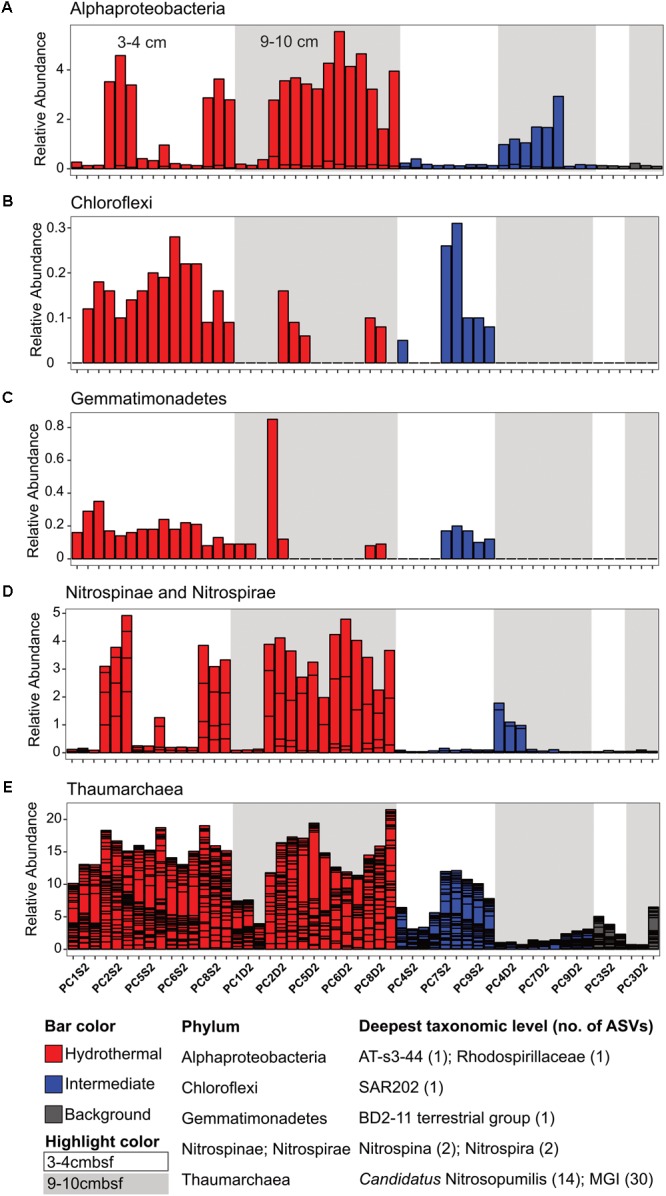
Select ASVs associated with (A) Alphaproteobacteria, (B) Chloroflexi, (C) Gemmatimonadetes, (D) Nitrospinae and Nitrospirae, and (E) Thaumarchaea which were more abundant in the hydrothermal and/or the hydrothermal plus intermediate samples. Bars are colored by sample, and divided by ASV abundance. Relative abundance is in percent of total sequences per sample. The deepest taxonomic level assigned are listed next to the phylum followed by the number of ASVs graphed.